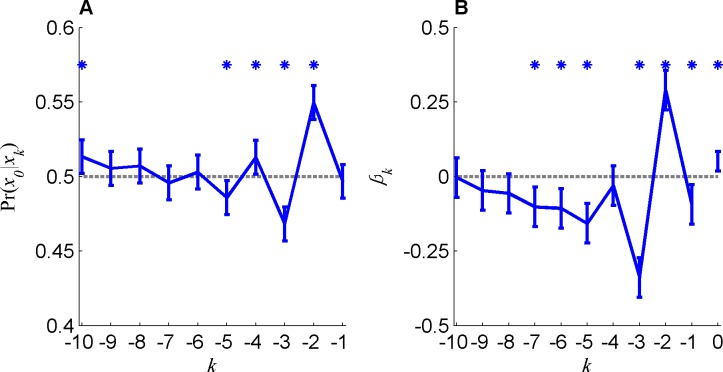
Sequential effects in random sequence generation task.A. The conditional probabilities Pr(x0 = H|xk = H) of generating H in a current trial (x0 = H), conditioned on a choice H–k trials ago. B. Logistic regression model's coefficients. Dashed gray line represents the null hypothesis of no sequential effect. Error bars represents the confidence interval at significance level of 0.005 (Bonferroni correction for multiple comparison) and stars denoted statistical significance assuming normal distribution of noise (t-test).